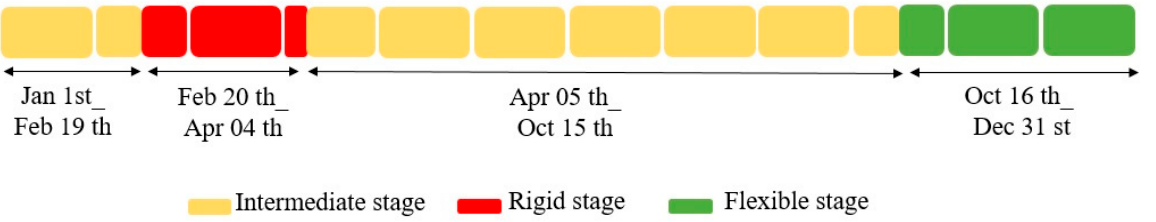
Figure 2. Municipal Plan Stages for the functioning of economic activities at Uberlândia.